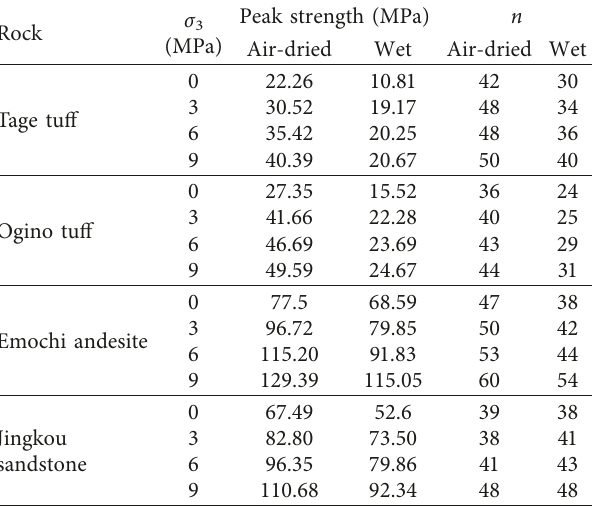
Figure 7: Relationship between n Table 4: Calculated results of n